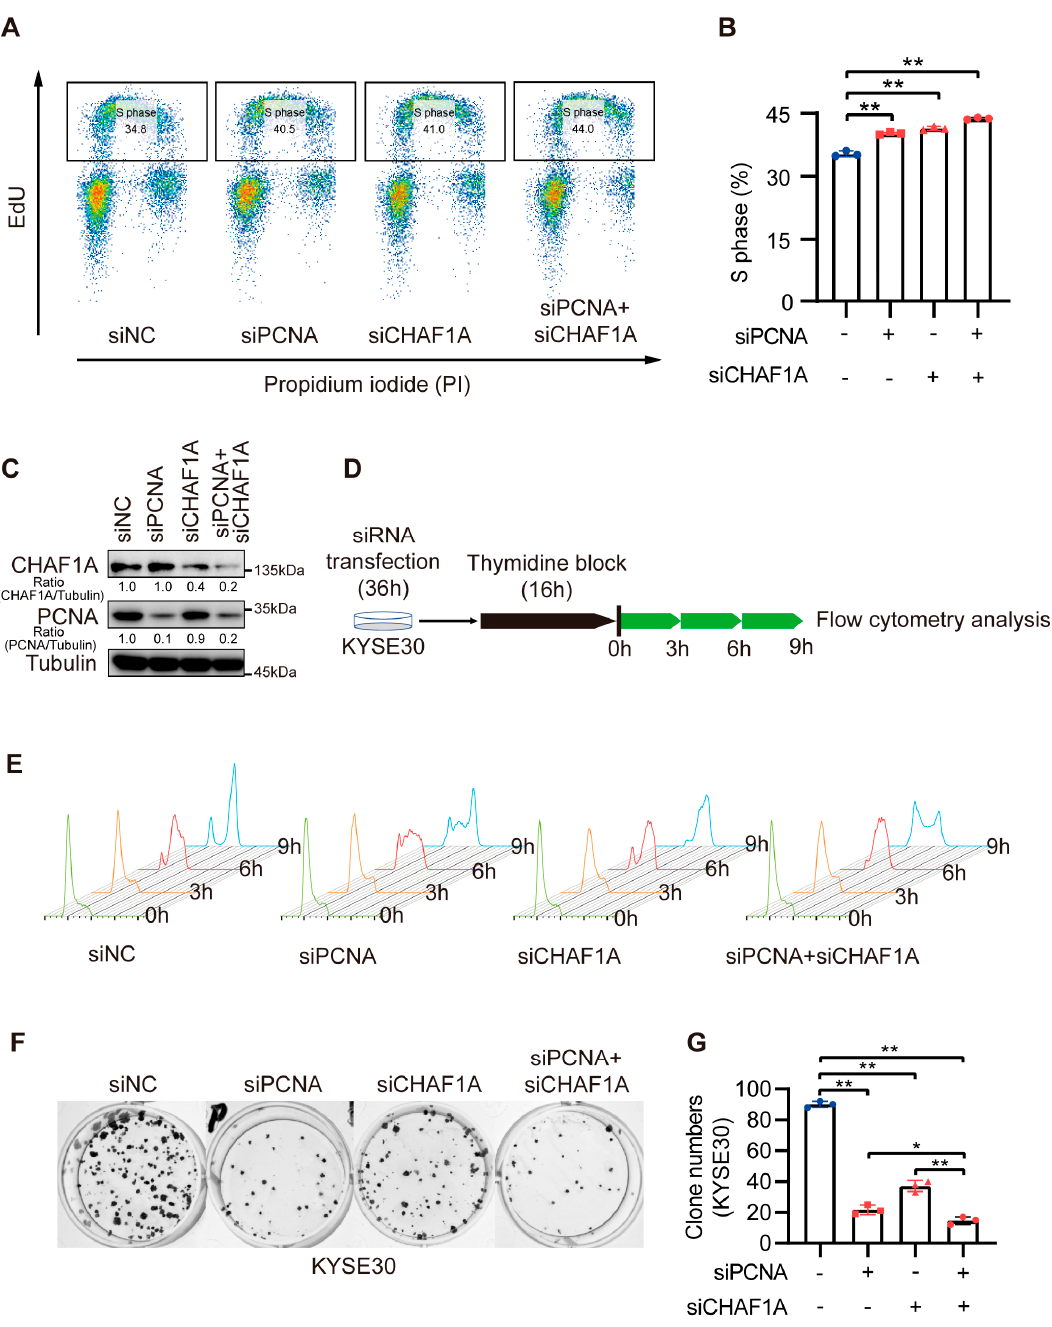
Figure 5. Double knockdown of CHAF1A and PCNA increases the proportion of EC cells in S–phase. ( A , B ) Flow cytometry analysis of EdU and propidium iodide (PI) staining in KYSE30 cells transfected with siNC, siPCNA, or siCHAF1A. The percentage of S phase cells is shown (n = 3). ( C ) Knockdown efficiency was detected using western blotting. ( D , E ) Schematic of cell cycle synchronization in KYSE30 transfected with siNC, siPCNA, or siCHAF1A. Flow cytometry analysis of the cell cycle was performed using FlowJo software. ( F , G ) Representative images (left) and colony quantification (n = 3; right) of KYSE30 cells. siRNA pools were used for single or/and double PCNA and CHAF1A knockdown. * p < 0.05, ** p < 0.01.